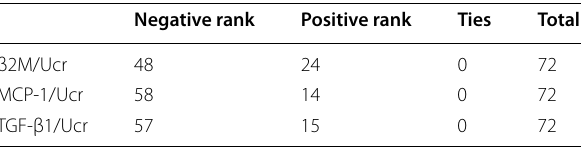
Table 2 Distribution of positive and negative